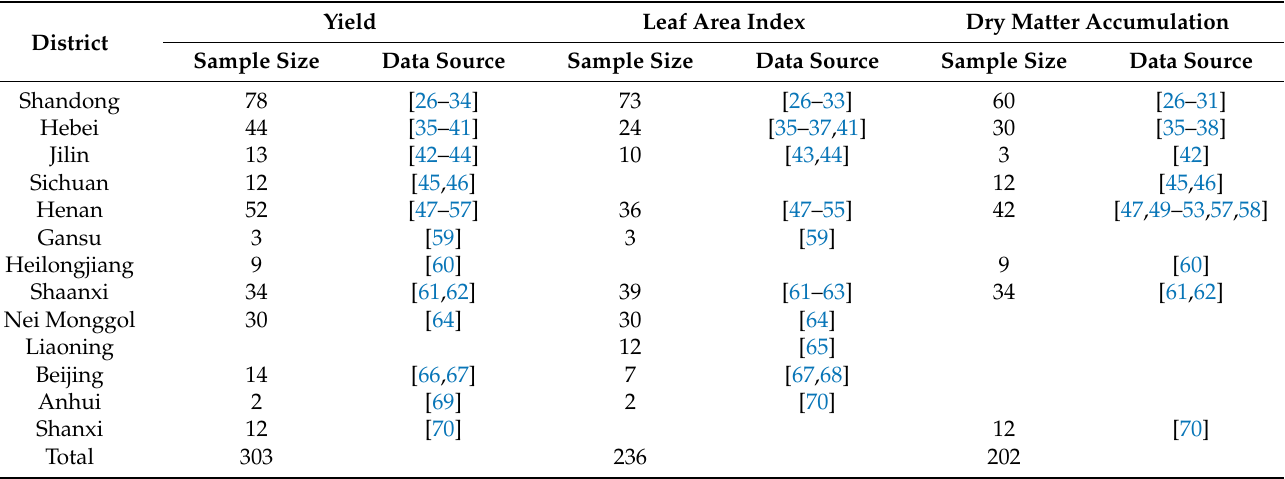
Table 1. Data sources and sample